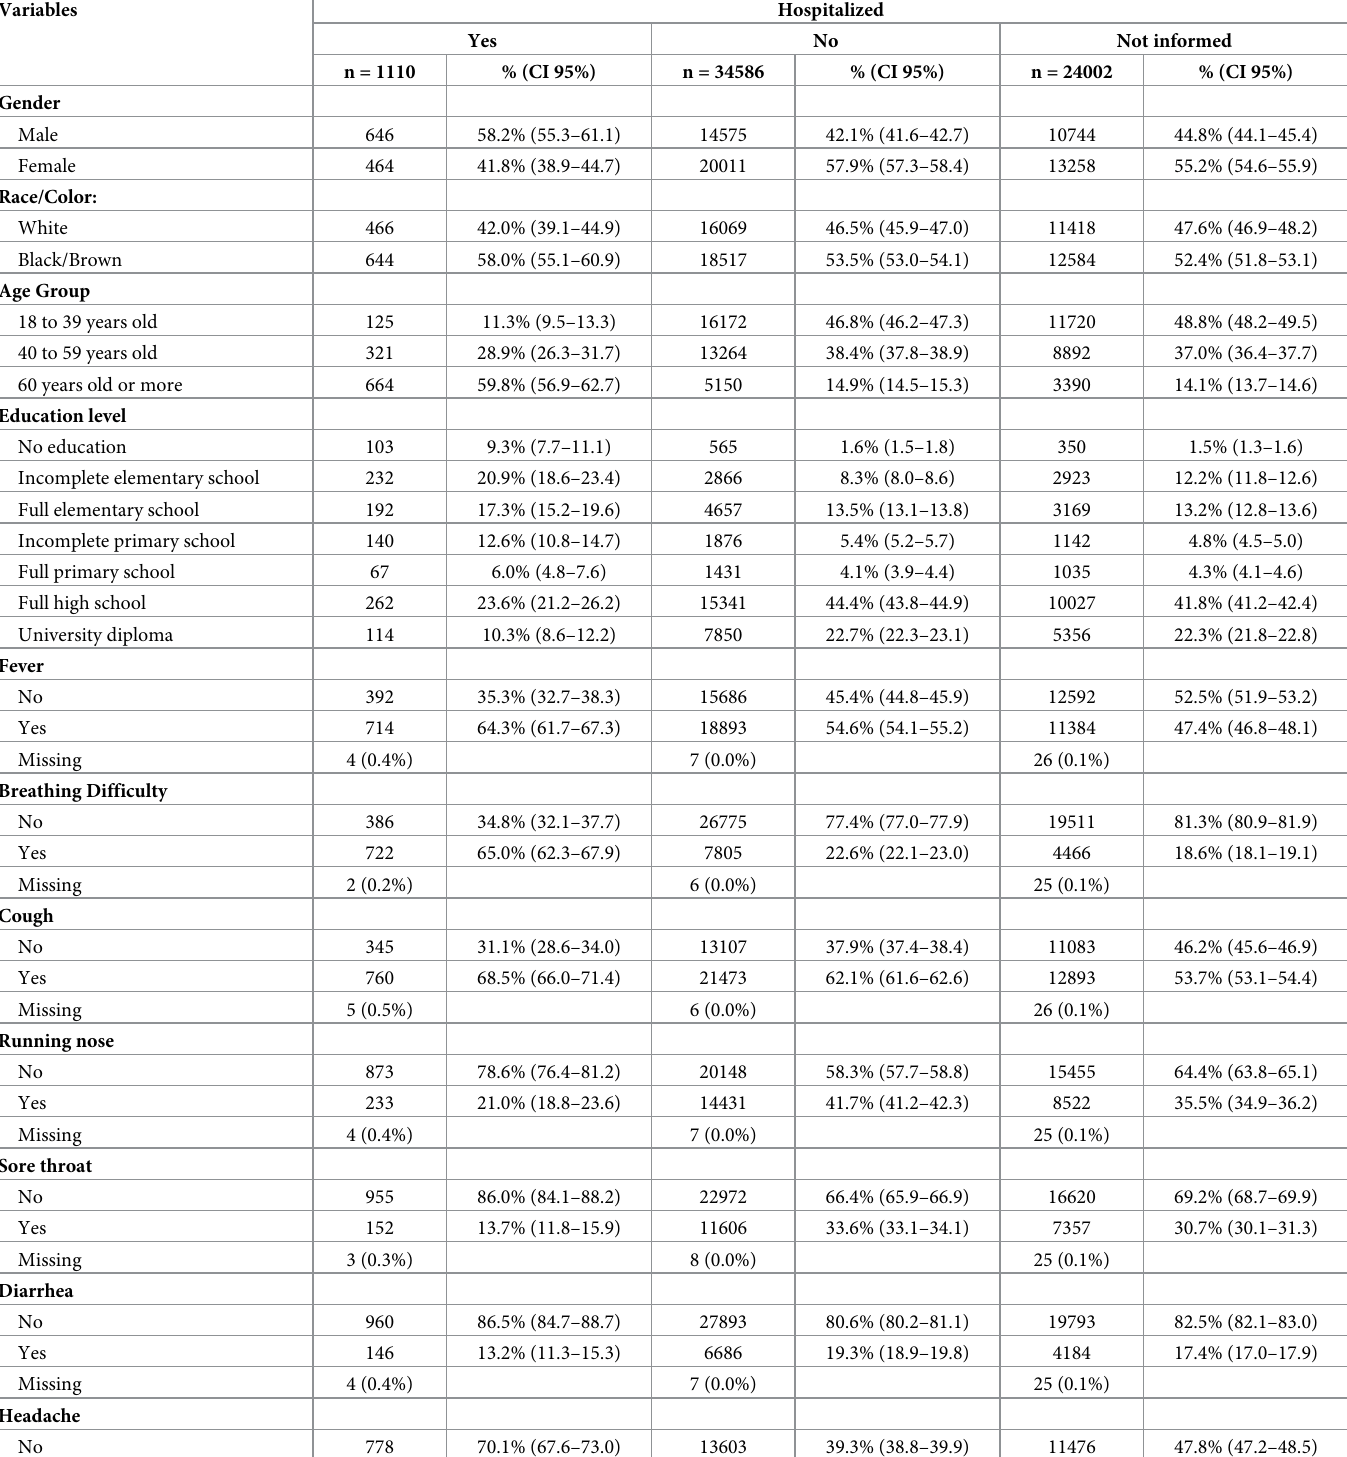
Table 1. Sociodemographic characteristics, comorbidities and signs and symptoms of confirmed and hospitalized cases with COVID-19, Espı´rito Santo, Brazil, 2020.